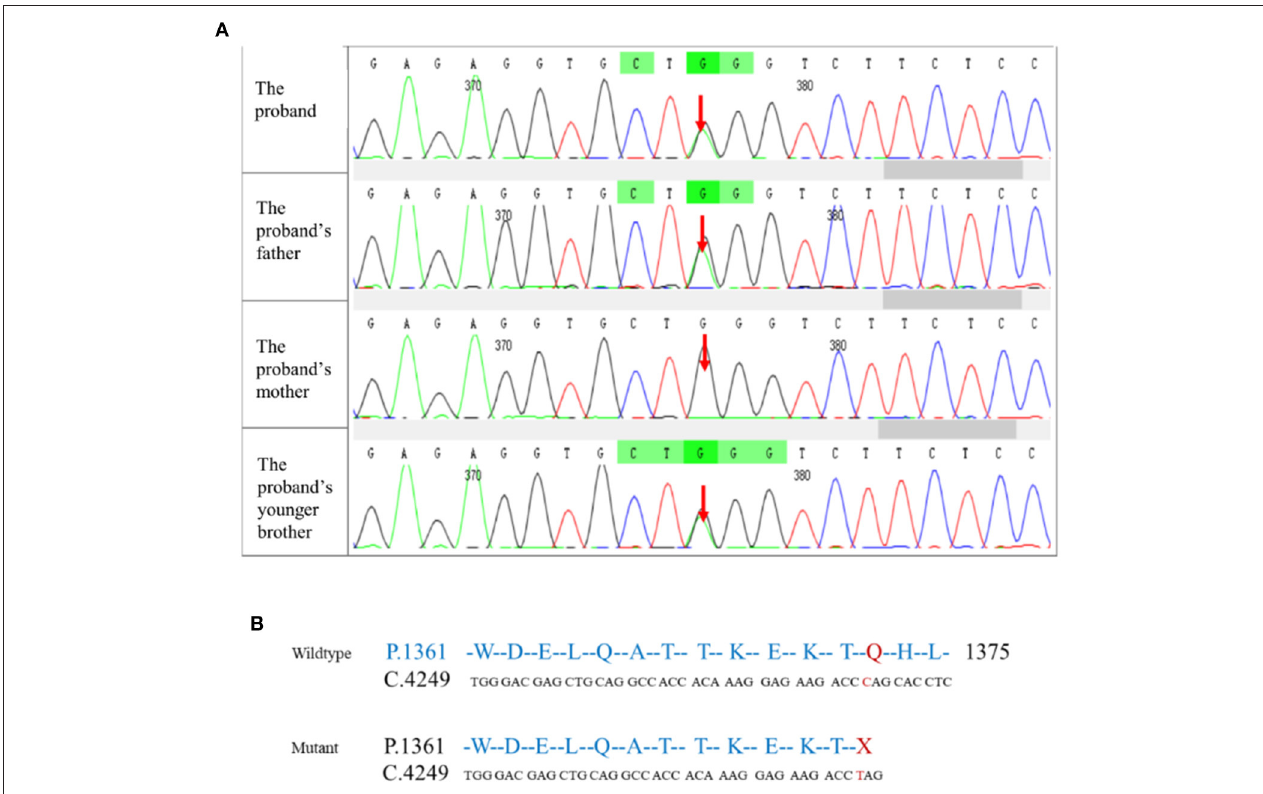
FIGURE 2 | Mutation testing analysis of the SPTB amino acid sequence. (A) NGS correlation peak map; (B) Wildtype and mutant SPTB sequences.